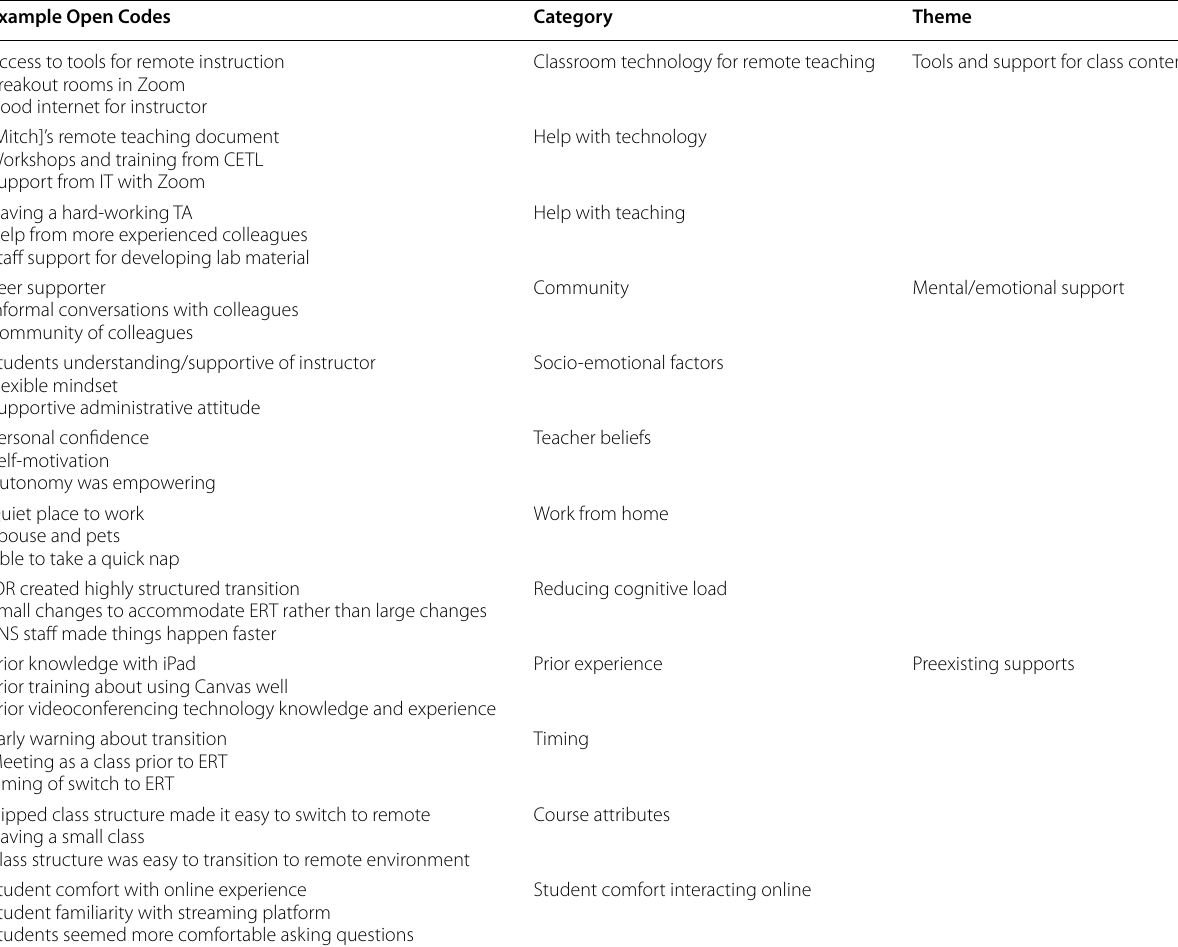
Table 9 Themes, categories, and example open codes for supports Example Open